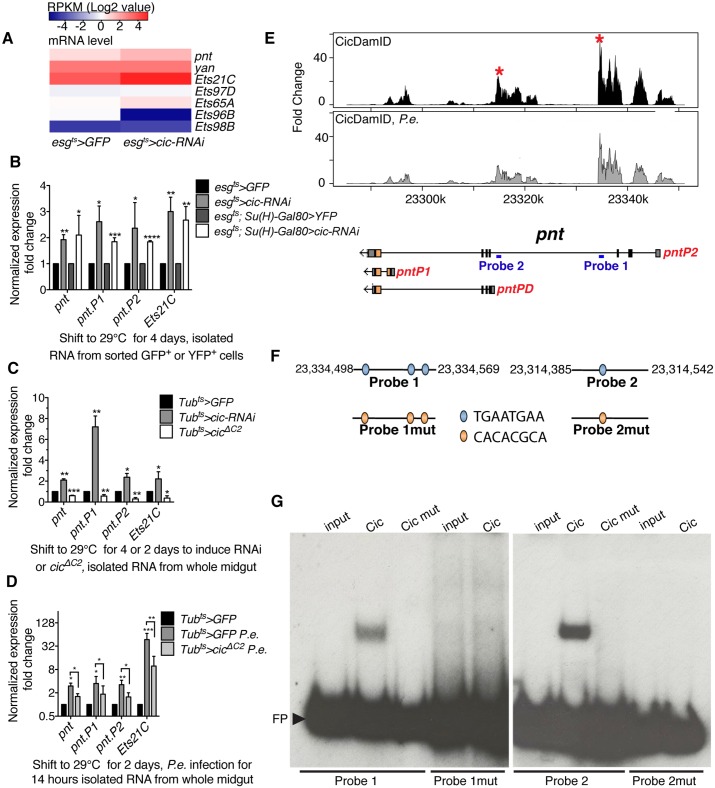
Cic regulates Pnt expression through binding to its genomic locus.(A) Heatmap of mRNA levels indicating RPKM values from RNA-Seq data from control and cic-RNAi expressing, FACS-sorted progenitor cells. (B-D) Relative expression of pnt, pntP1, pntP2 and Ets21c as analyzed by qRT-PCR and normalized to β-Tub and Rp49. (B) Fold change of expression from the cic depleted FACS-sorted progenitor cells and ISCs. (C) pnt, pntP1, pntP2 and Ets21C were upregulated in cic knock down midguts and downregulated in cic overexpressing midguts. (D) Expression change in cic overexpressed midgut after P.e. infection. Error bars represent standard deviation. Statistical significance was determined by Student’s t test (*p<0.05, **p<0.01, ***p<0.001, ****p<0.0001). (E) Cic binding sites in the pnt locus, as determined by Cic DamID-Seq of esg+ progenitor cells from control and P.e. infected midguts. Vertical bars represent the log2 ratio of the Dam-fusion signal to the Dam-only signal. Peaks also found in Cic ChIP-Seq from embryos are marked by asterisks. Positions of EMSA probes from the pnt locus are indicated by blue bars. (F) Diagram of probes containing TGAATGAA sites. These sites were replaced with other sequences in probes 1 and 2 to generate probes 1mut and 2mut. (G) DNA binding of Cic and HMG-box mutated Cic to probe 1 or 1mut (left panel). DNA binding of Cic and HMG-box mutated Cic to probe 2 or probe 2mut (right panel). FP indicates “free probes.”